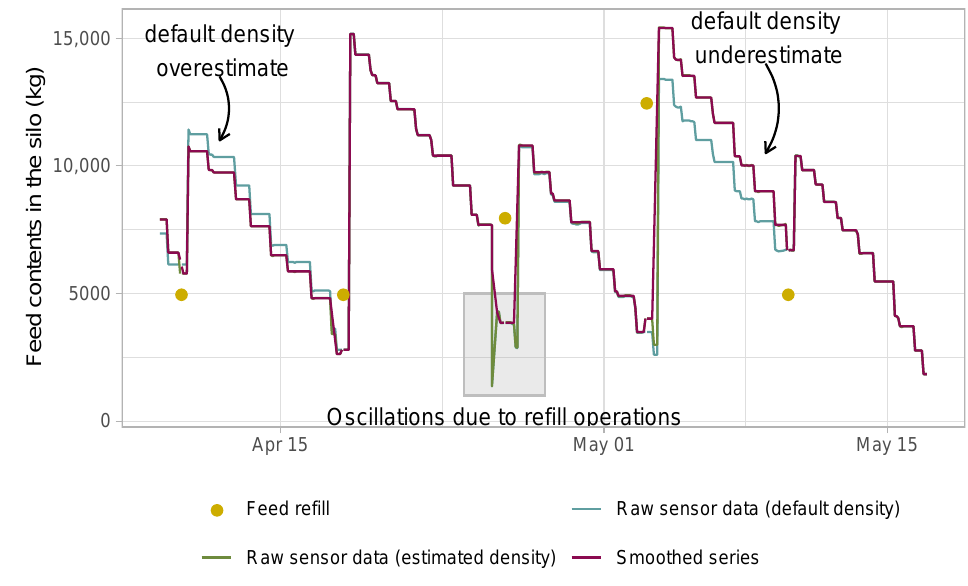
Figure 7. Time series of the silo contents estimated from the sensor